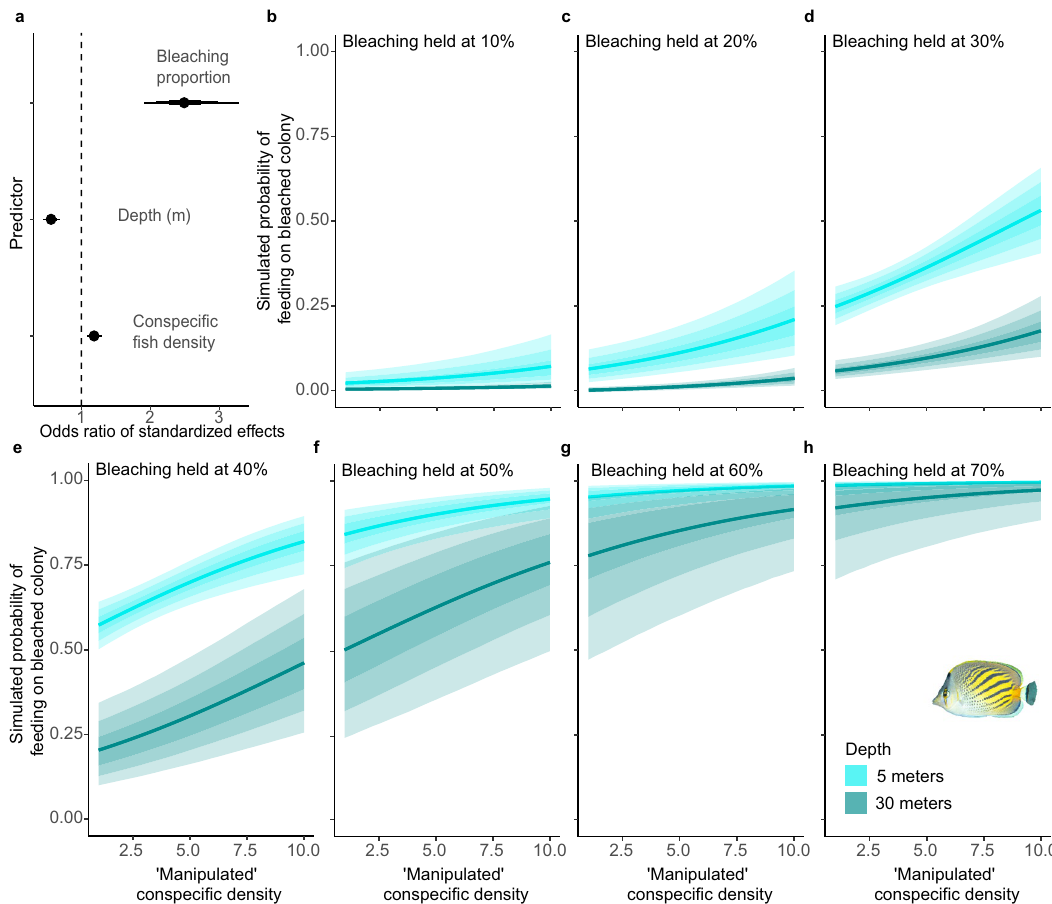
Figure 5. ( a ) Counterfactual plots showing the predicted effects of increasing conspecific density (1–10 conspecific individuals 40 m −2 ) on the probability of C. pelewensis feeding on a bleached coral colony (in any given bite) at each of two depths (5 m, 30 m) when the proportion of bleached coral colonies is held at each of seven fixed values (10–70%). ( a ) The odds ratios of effects for the three (standardized) predictors used in the model that the counter factual plots are built from. In ( b-h ), the gradated fills represent the 60%, 80% and 95% compatibility intervals (posterior mass) for each prediction. In ( a ), these same three intervals are shown with decreasing thickness of the three stacked error bars for each predictor. An odds ratio of 1 (indicated in ( a ) by the vertical dashed line) indicates no change in the odds of feeding on a bleached coral as the value of the predictor